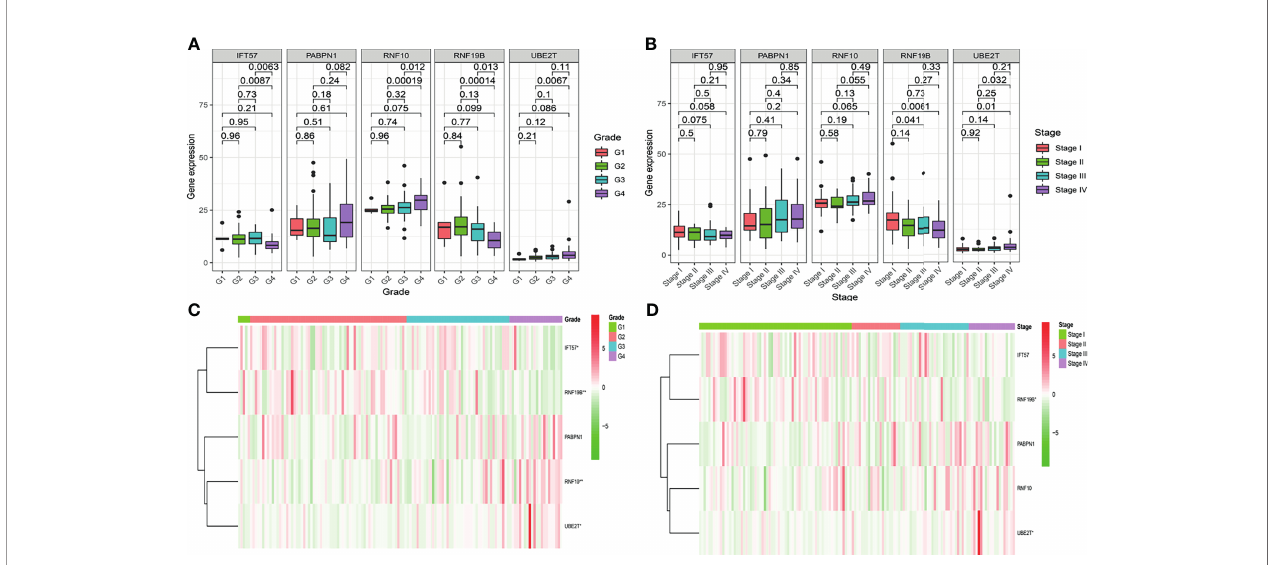
FIGURE 4 | The correlation between the hypoxia-related prognostic genes and clinical pathological, such as Grade (A, C) and Stage (B, D) , in the training cohort.